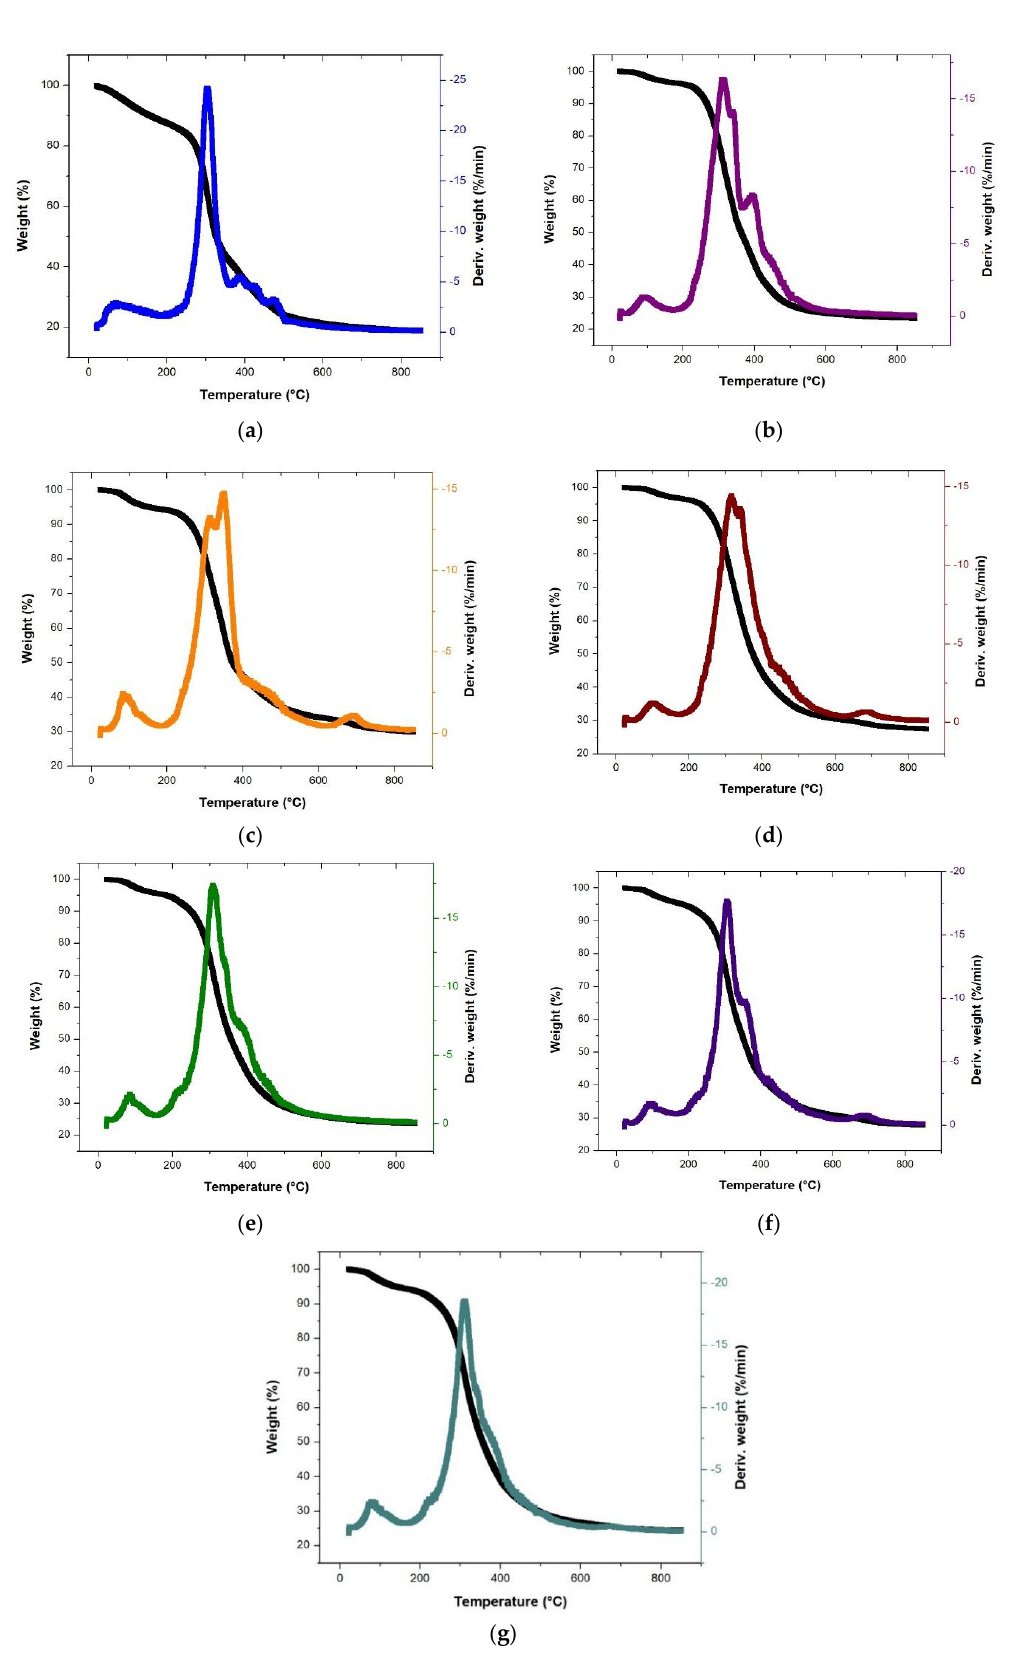
Figure 1. TGA and DTG curves for the single DP ( a ), CW ( b ), and CD ( c ), binary CW:CD ( d ), DP:CW ( e ), and DP:CD ( f ), and ternary DP:CD:CW ( g ) biomass waste feeds. The volatiles generated during the fast pyrolysis of single, binary, and ternary wastes were analyzed using Py/GC – MS. The products are conventional compounds, unlike bio- mass feeds. The identified compounds with >80% similarity to those from the NIST library and areas higher than 2% are presented in Table 3. The number of identified compounds for DP, CW, CD, CW:CD, DP:CW, DP:CD, and DP:CD:CW are 14, 13, 11, 9, 12, 15, and 10, respectively. According to the identified compounds, the bio-oil components are broadly identified as aldehydes, amines, aliphatic compounds, aromatics, alcohols, furans, ke- tones, and acids (Figure 2a). Recent studies report that similar functional groups have been identified by fast biomass pyrolysis in several other studies using oilfield sludge [23], pecan nutshell [24], jatropha waste [25], and wheat stalk [26]. The finding is also consistent with an earlier study which stated that, despite the biomass feed, the bio-oil consists of acids, alcohols, phenols, aldehydes, ketones, aromatics, and furans, regardless of the type of feedstock [27]. The three single-biomass pyrolysis products have four compounds in common, acetic acid and ketone groups (acetic acid, 2-Propanone, 1-hydroxy-, Benzyl me- thyl ketone, and 1,2-Cyclopentanedione). Acetic acid is known to be a main bio-oil com- ponent in spent coffee grounds [15], date palm biomass [28], and cattle manure [29]. Fur- thermore, the results show that DP and CW have seven of the categorized functional com- pounds, but CD has six (Figure 2b). The binary feeds share six compounds, and the ter- nary feeds comprise three compounds similar to single and binary feeds. The area per- centage reflects the quantity of the compounds, and Figure 2b shows that the highest amounts are for the acids or ketones, depending on the feed. The ketones are the majority for all the feeds except the ternary mixture (acids comprise 32.91%, very close to the ketone content of 32.89).